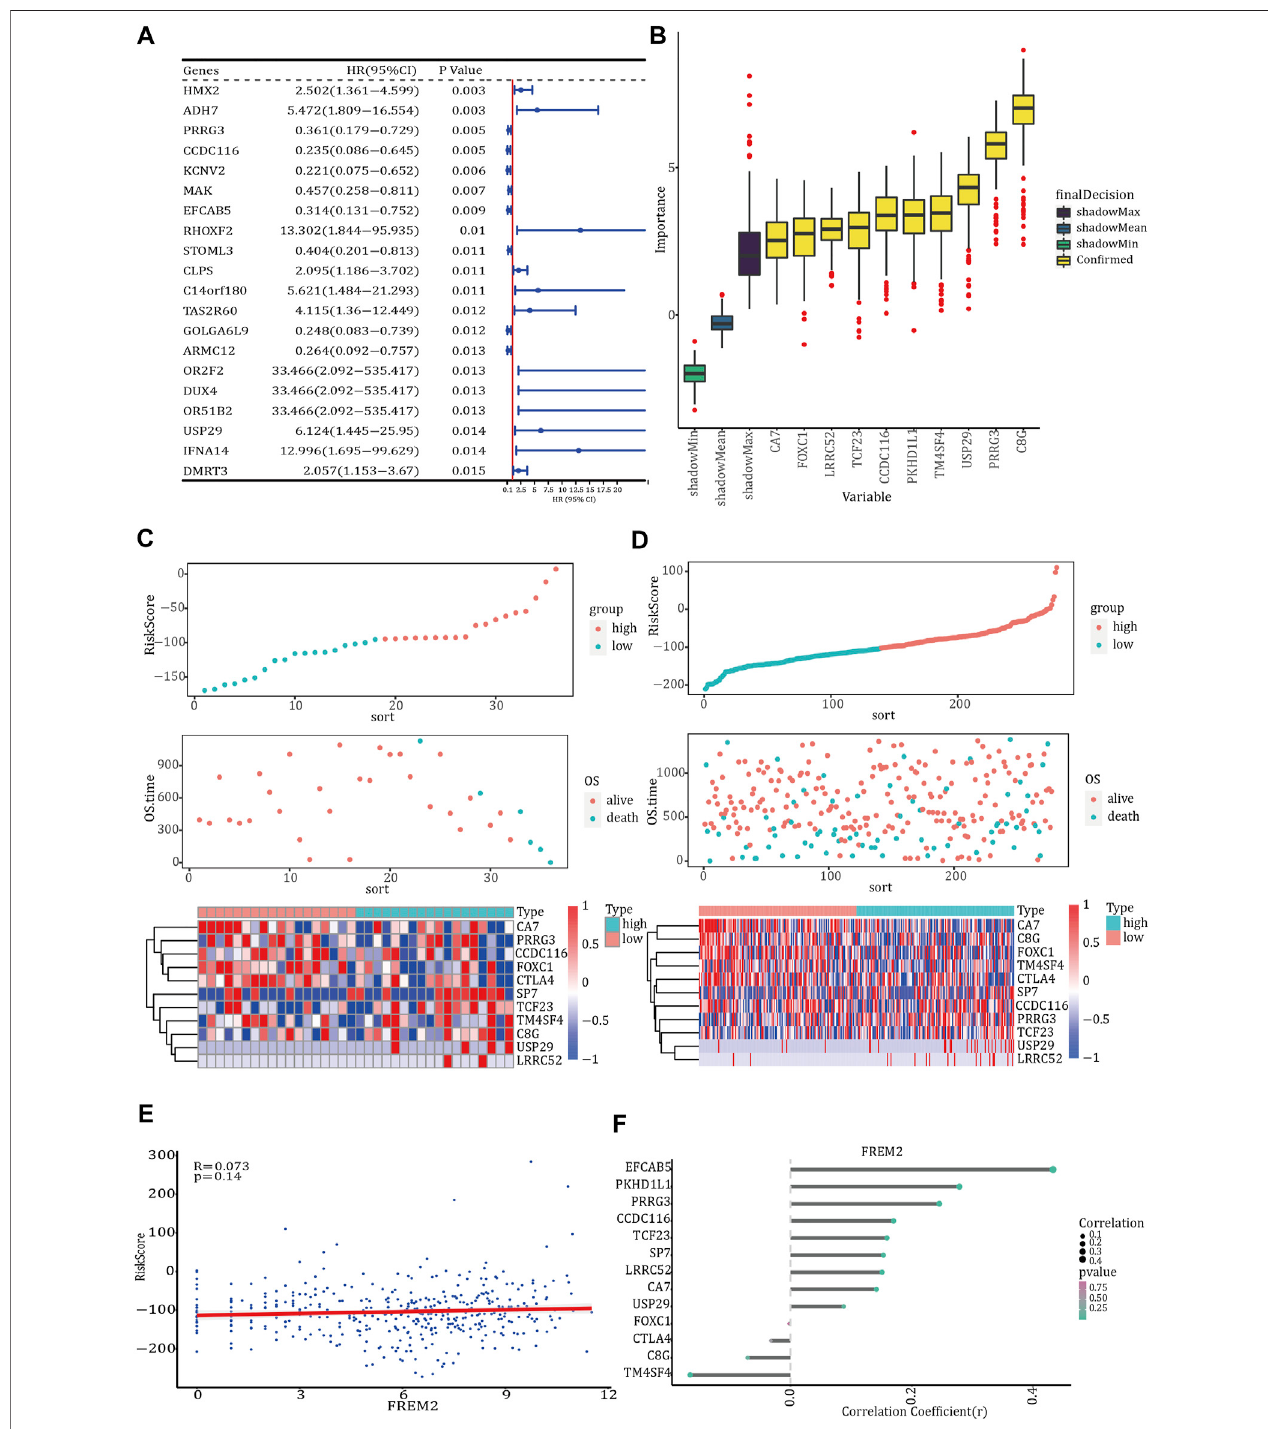
FIGURE3| Prognosismodel of FREM2 mutation. (A) Theforest plotofthetop20prognosis-related genesobtainedbyunivariate Coxregressionanalysis.Theleft side of the vertical dashed line shows the protective gene, and the right-side shows the risk gene. (B) The 13 important features selected based on random forest. Risk score, survival status and characteristic gene expression analysis of FREM2 -mutant type (C) and FREM2 -wild type (D) . (E) Scatter plot of the correlation between FREM2 expression and risk score. (F) Correlation between the expression levels of FREM2 and characteristic genes. The size of the dot represents the strength of the correlation between FREM2 and the characteristic gene; the larger the dot, thestronger the correlation, and viceversa. The color ofthe point represents the p value. The greener the color, the smaller the p value, and the pinker the color, the larger the p value. p value < 0.05 was considered statistically signi fi cant.